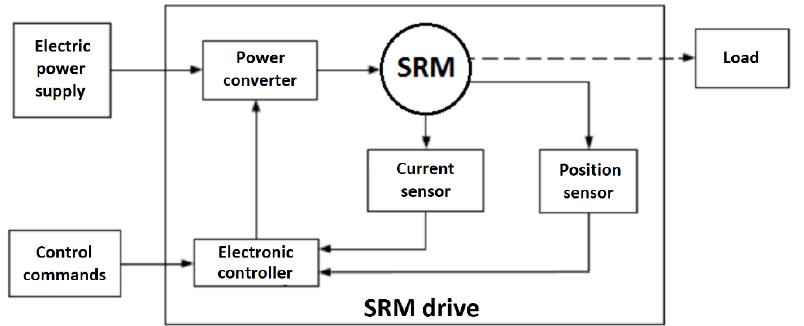
Figure 7. Block diagram of the proposed SRM drive.